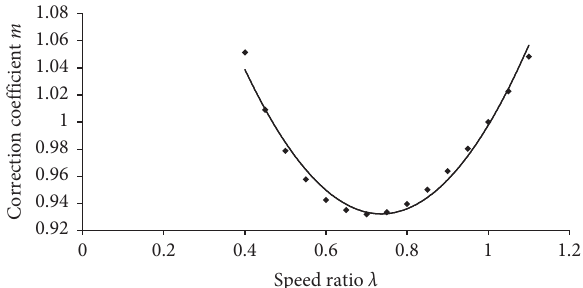
Figure 5: Correlation between m and λ for a minibus.